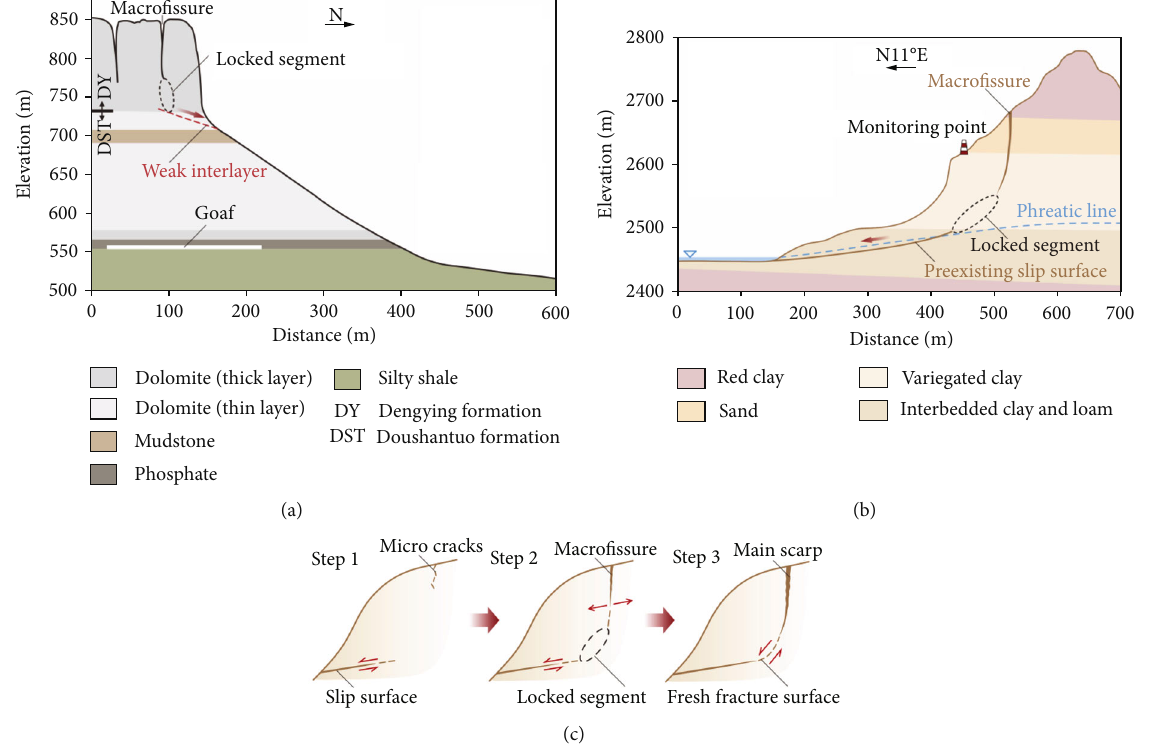
Figure 1: Geological pro fi les of the (a) Yanchihe [7] and (b) Longxi slopes [8], and (c) typical formation and failure processes of a locked segment. Step 1: a bottom slip surface develops or preexists. Step 2: tension cracks form a macro fi ssure with slope deformation, where the intact part between the fi ssure and bottom slip surface serves as a locked segment. Step 3: the locked segment becomes unlocked and landslide occurs.